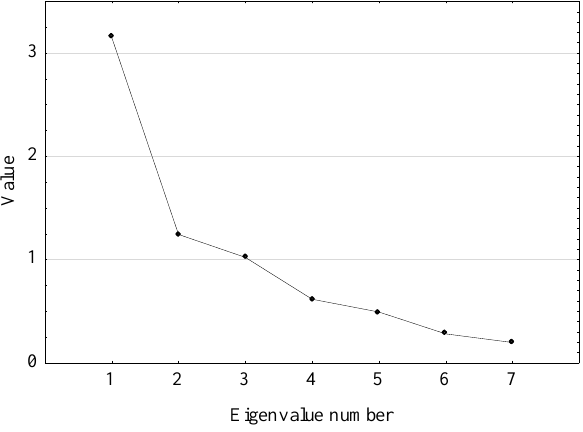
Figure 4. Diagram of factor loads.